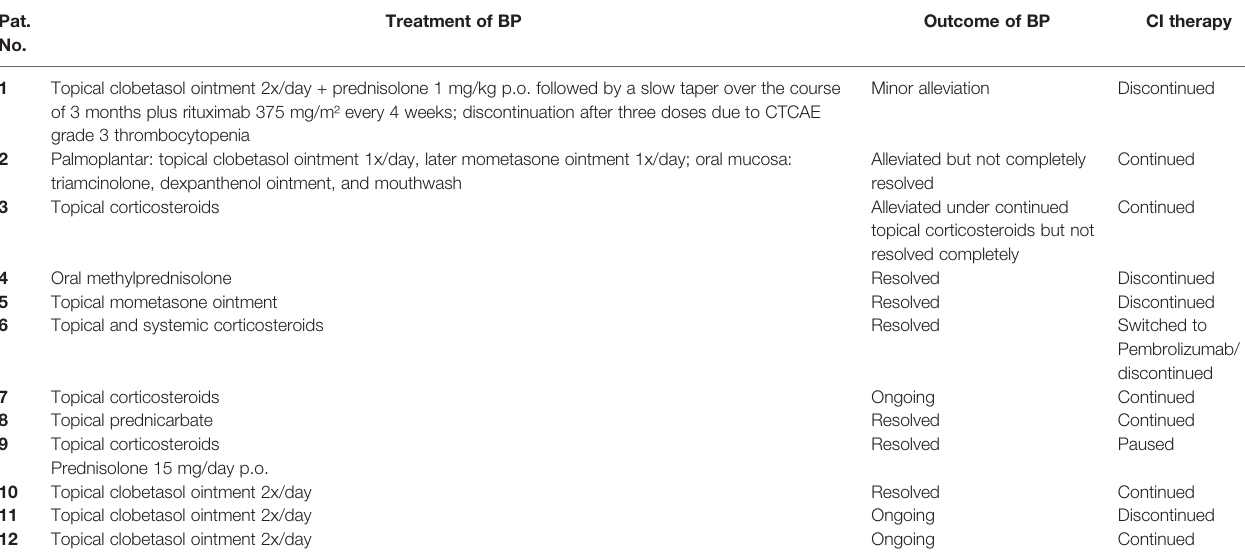
TABLE 3 | Management and outcome of bullous pemphigoid (BP). Pat.